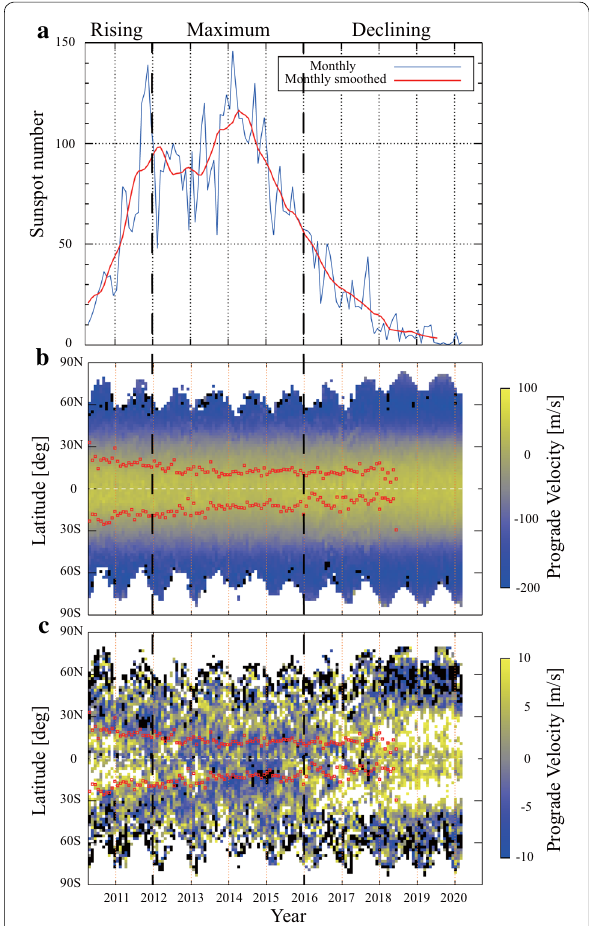
Fig. 1 Solar cycle-related variation of the differential rotation speed during solar cycle 24 obtained by the magnetic element feature tracking technique: a temporal variation of the sunspot numbers (data are from the Royal Observatory of Belgium), b temporal variation of the differential rotation speed, and c differences in the differential rotation profiles from the average are